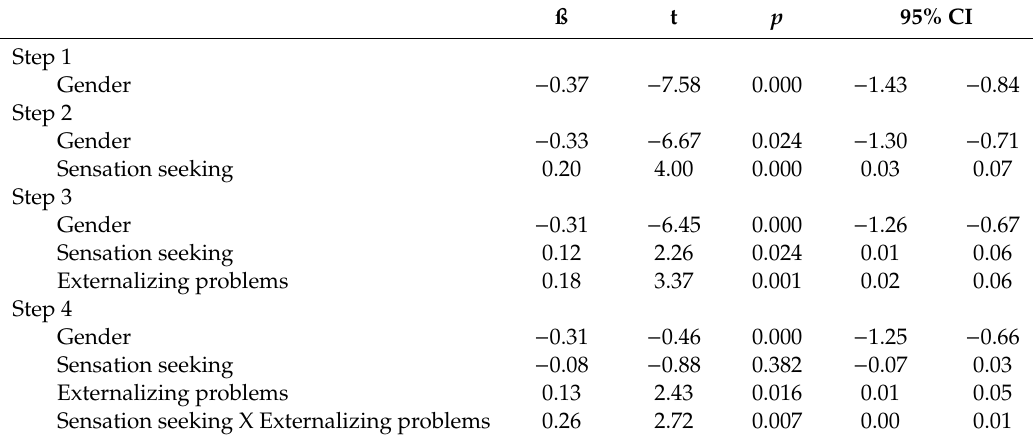
Table 2. Hierarchical regression analysis results for externalizing problems and sensation seeking as predictors of gambling